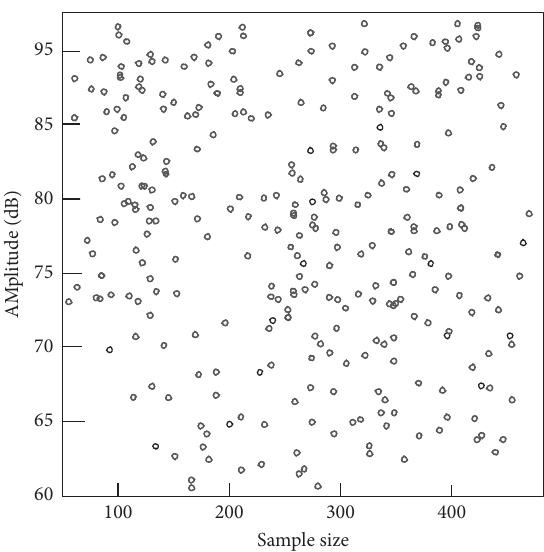
Figure 4: Sample distribution of international law data series. Table 1: Comparison of experimental parameter